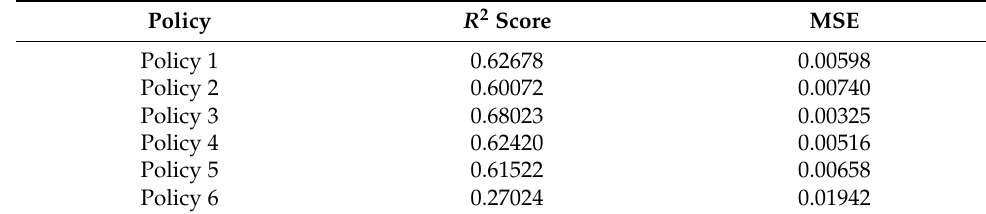
Table 7. Results Obtained From the Driving Situations Policies.